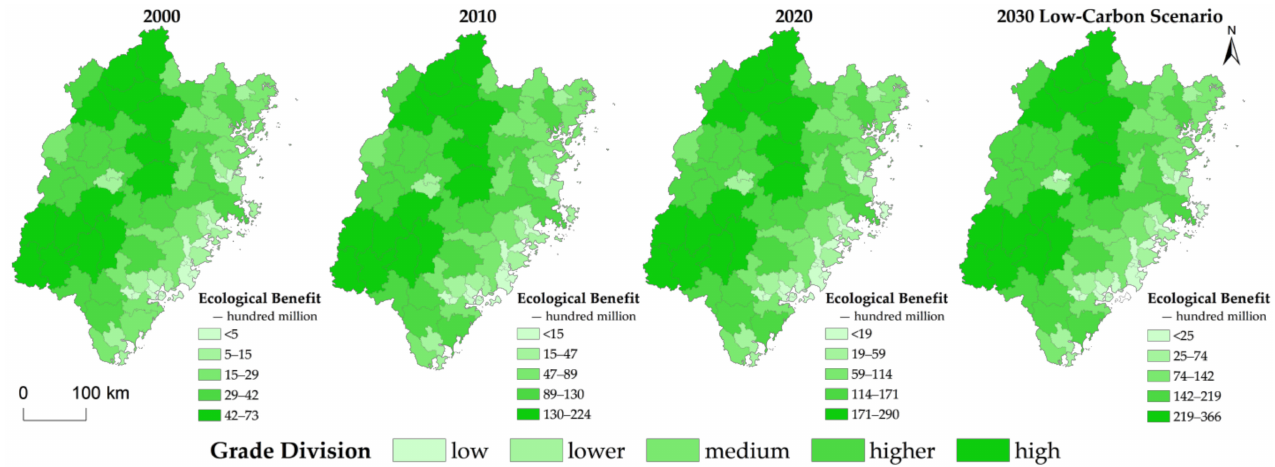
Figure 7. Evolution of spatial pattern of the ecological benefit of land use in Fujian